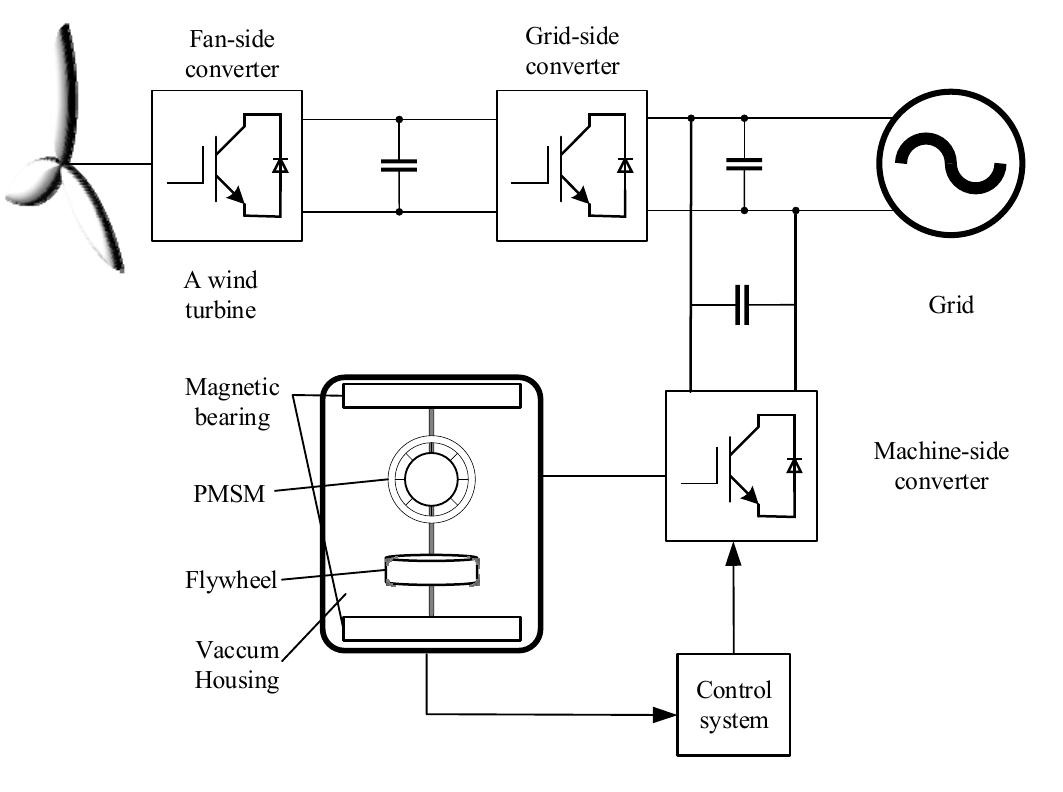
Figure 1. Structure diagram of FESS with wind power for frequency modulation.